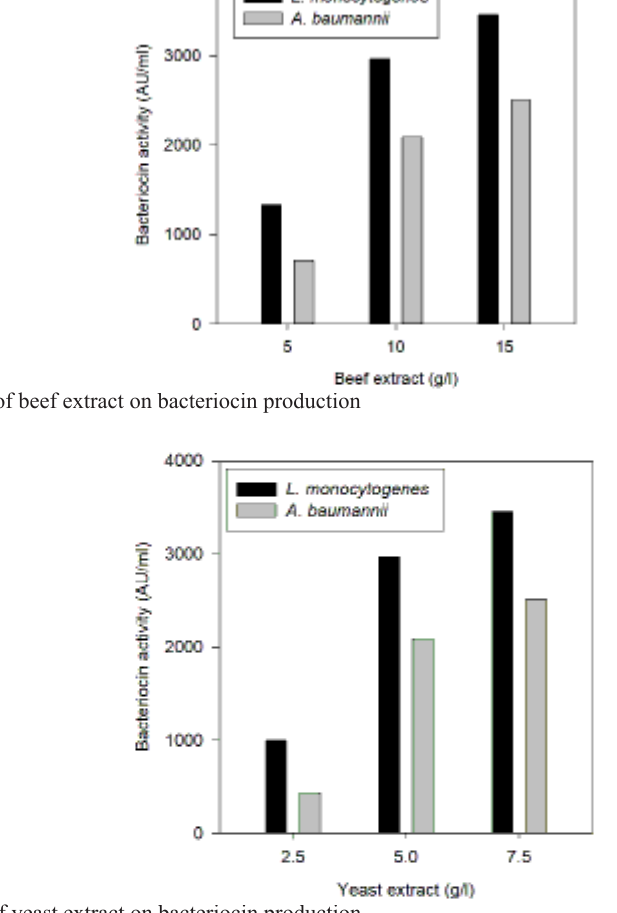
Fig. 7. Effect of yeast extract on bacteriocin